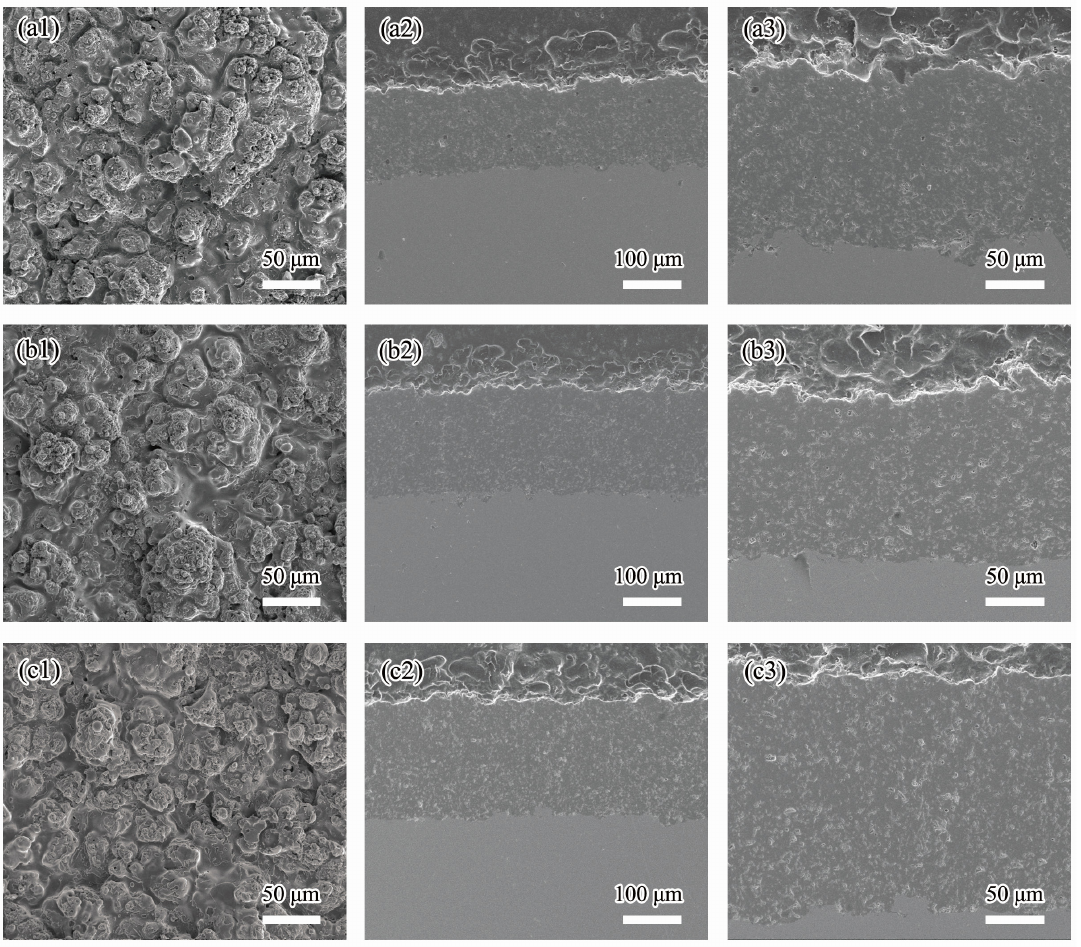
Figure 3. SEM images of TiO 2 coatings: ( a1 – a3 ) TiO 2 ‐ 12 ‐ 0, ( b1 – b3 ) TiO 2 ‐ 12 ‐ 30, and ( c1 – c3 ) TiO 2 ‐ 20 ‐ 30.